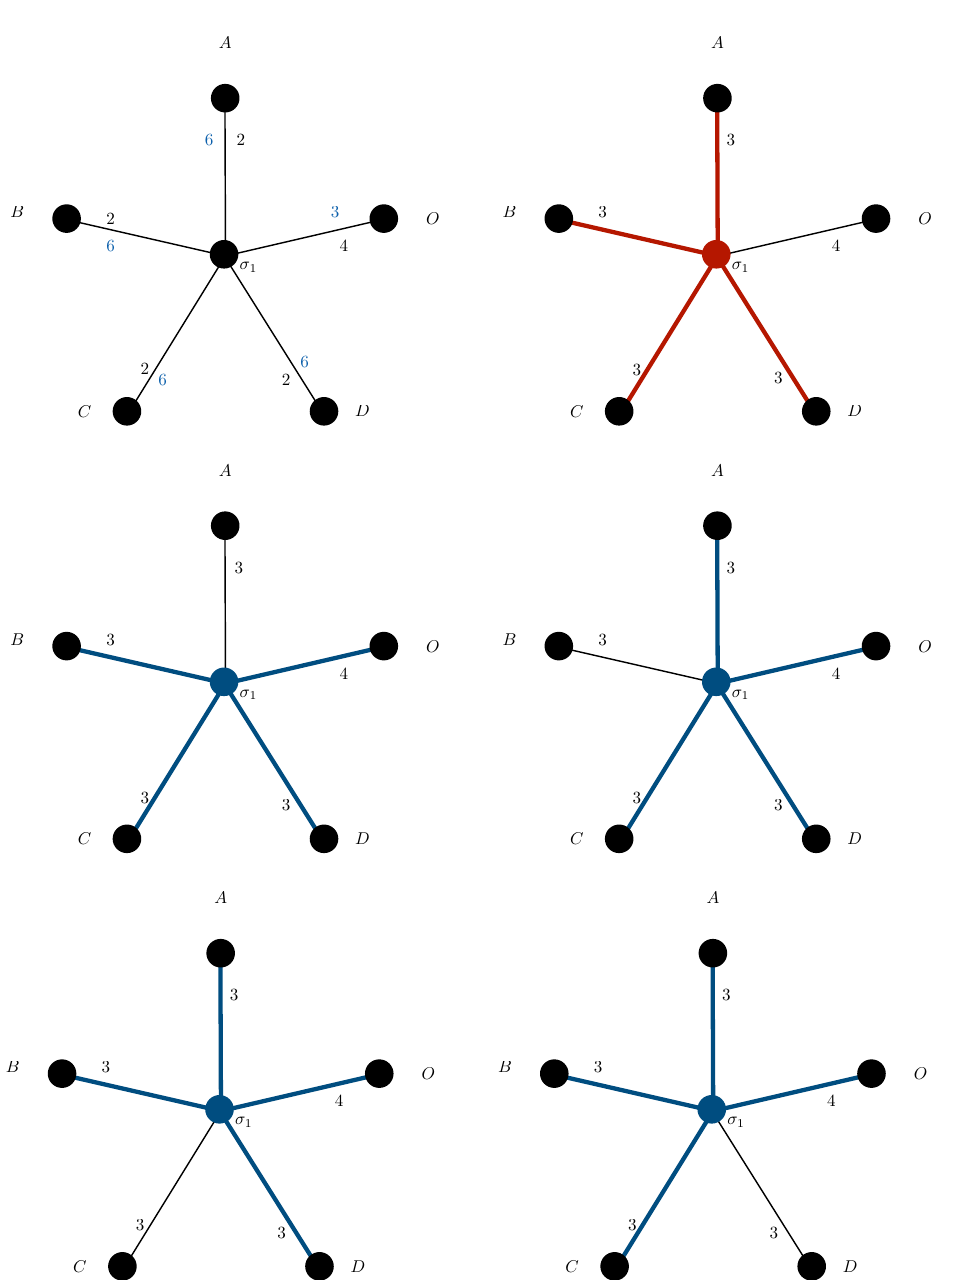
Figure 22 . TL: the edge capacities are in black while the optimal barrier configuration for each edge is in blue. This configuration corresponds to α = 1 such that each thread of H ( ABCD ) 3 O crosses a barrier of exactly 21 while H crosses a barrier of exactly 24. TR: the negative A : B : C : D thread h corresponding to µ ∗ = − 1 . Shown are the updated edge capacities corresponding to 2 ABCD the extra space the positive threads have available in the geometry. The remaining diagrams show the four positive threads comprising h corresponding to µ ∗ = 1 . Their placement on the 1 ( ABCD ) 3 O graph uses up all of the available capacity such that no additional threads can be